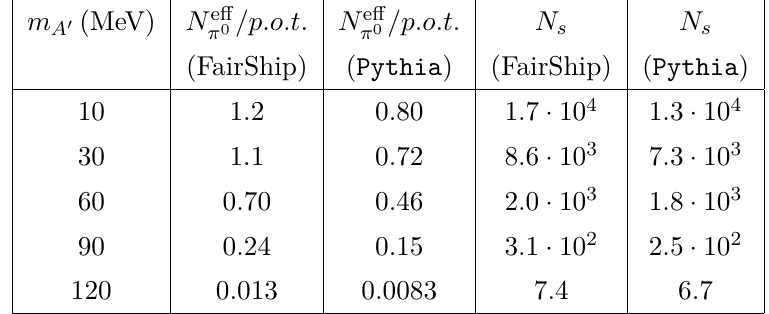
Comparison between π 0 samples generated using FairShip (with an energy cut of E cut > 500 MeV in secondary vertices) and Pythia . N eff /p.o.t. is the effective number of π 0 s π 0 per p.o.t. producing LDM particles within the geometrical acceptance. N is the signal yield for s the benchmark point α = 0 . 1 and m = 3 m and (cid:15) = 10 − 4 corresponding to 2 · 10 20 p.o.t. D A 0 χ